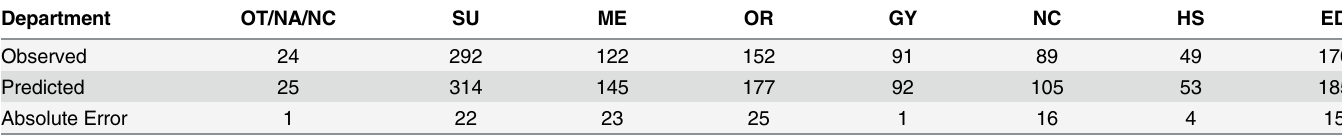
Table 10. Example of backtesting for claims due to alleged injuries for the Lombardia region. Observed (historical) claims against claims predicted for 2011. Department